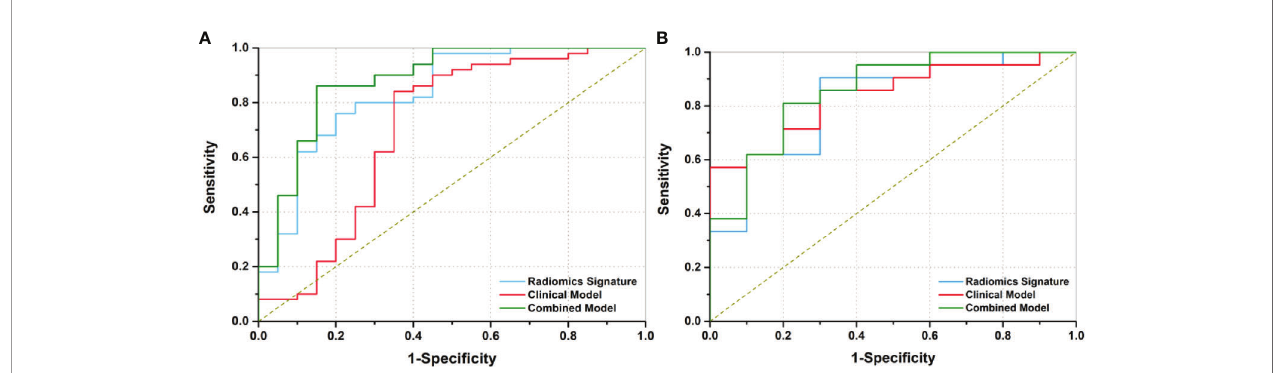
FIGURE 3 | Receiver operating characteristics (ROC) curves of three models to discriminate metastasis in preoperative ovarian cancer patients. (A) The area under curves (AUCs) of radiomics signature, clinical factor model, and combined model were 0.84 (95% CI, 0.74-0.93), 0.70 (95% CI, 0.58-0.83) and 0.88 (95% CI, 0.80- 0.96) in the training cohort, respectively . (B) The AUCs of the radiomics signature, clinical model, and combined model were 0.82 (95% CI, 0.66-0.98), 0.83 (95% CI, 0.67-1.00), and 0.86 (95% CI, 0.72-0.99) in the validation